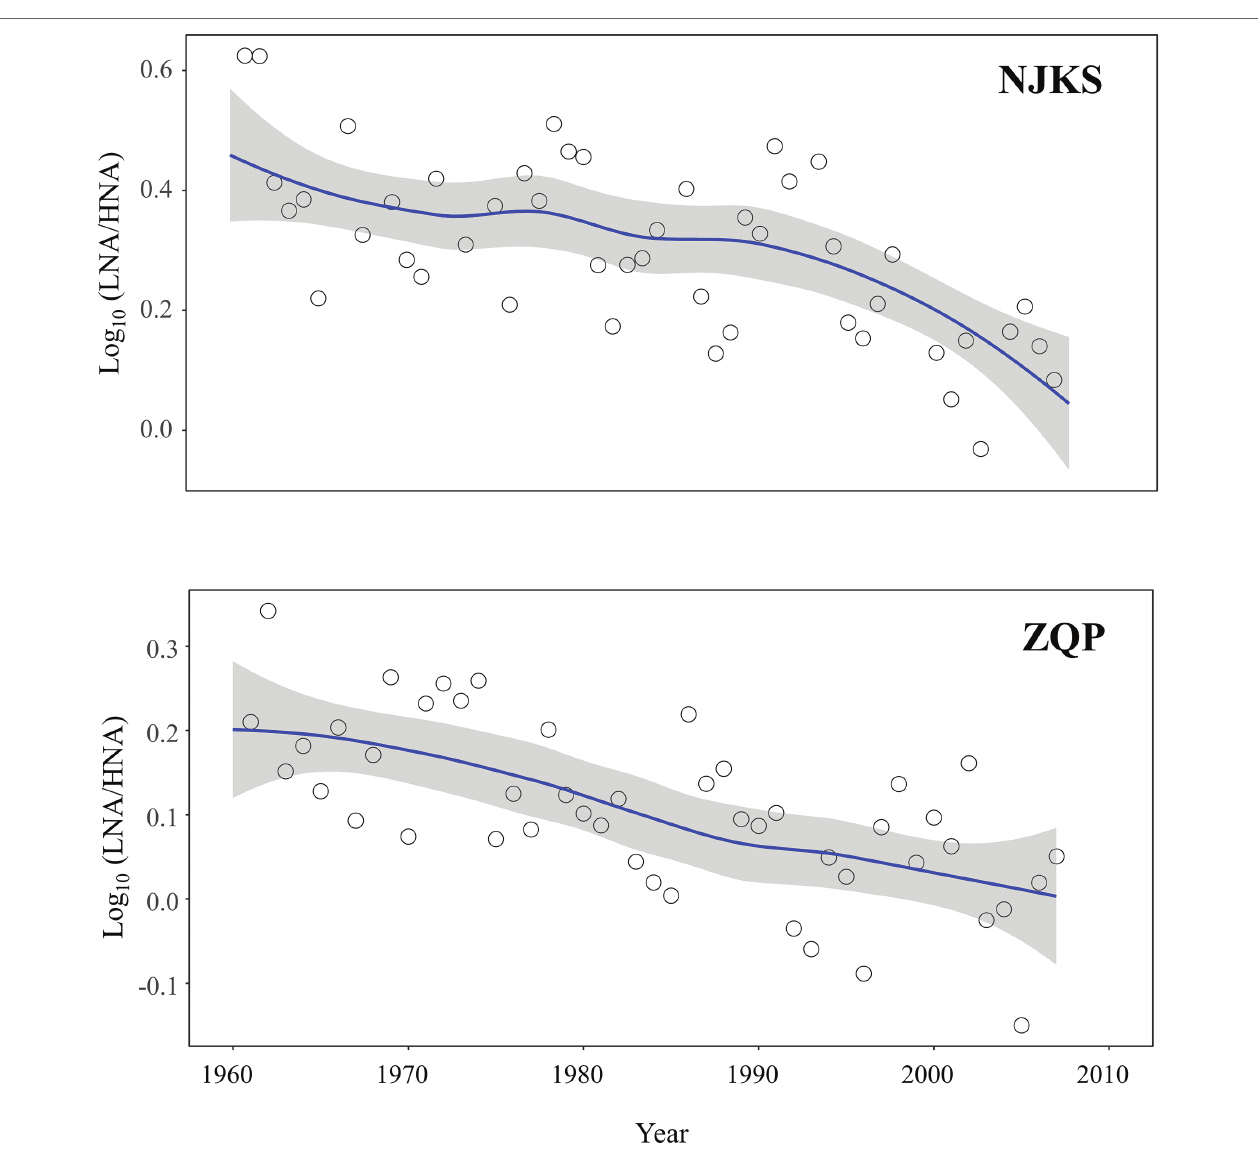
FIGURE 2 | Time trends (solid lines) of Log 10 (LNA/HNA) in NJKS (edf = 8.19) and ZQP (edf = 5.49) glacier ice cores. All trends were estimated using GAMs. The gray-shaded areas in the graphs represent the 95%